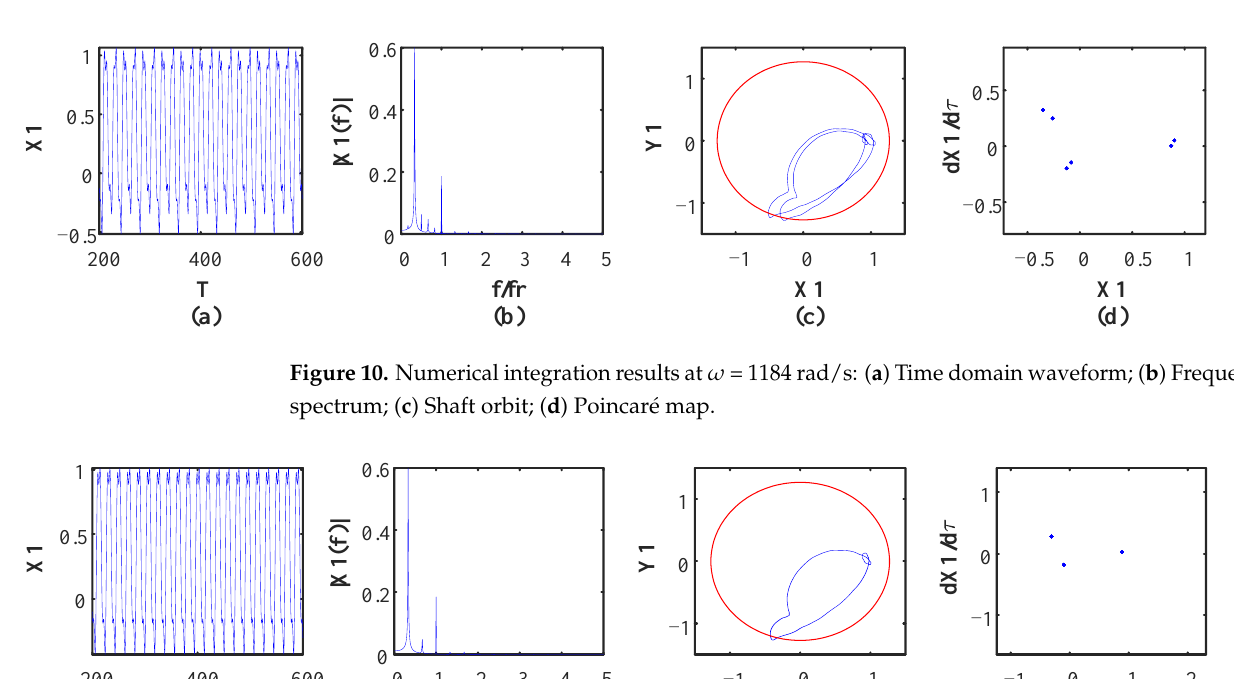
Figure 9. Numerical integration results at ω = 1046 rad/s: ( a ) Time domain waveform; ( b ) Frequency spectrum; ( c ) Shaft orbit; ( d ) Poincaré map.